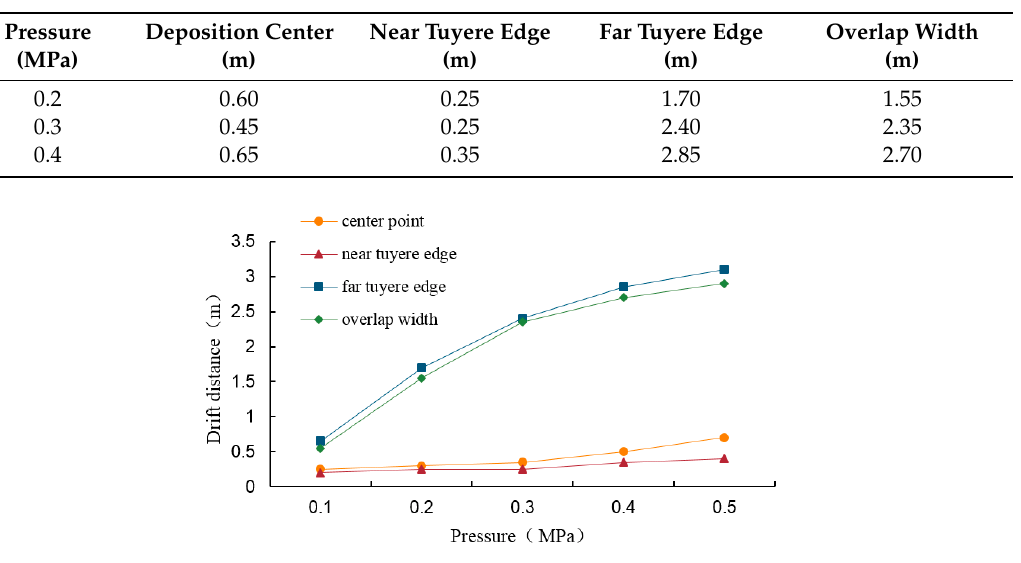
Figure 8. The relationship between pressure and drift distance (center point, near tuyere edge, far tuyere edge and overlap width).